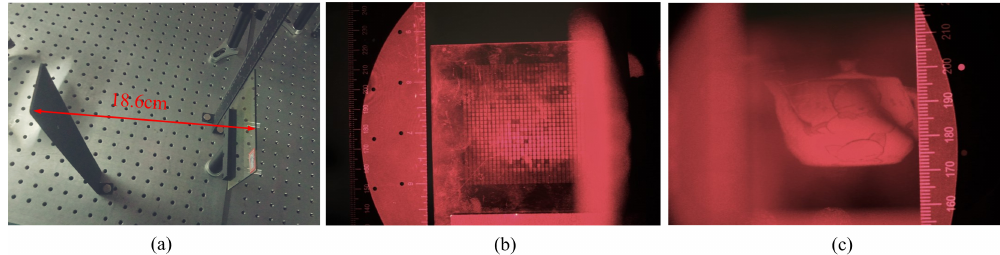
Figure 12. ( a )The spatial position relation of two rulers and the holographic plate. ( b ) Focused on the left ruler, both rulers the holographic plate are clear. ( c ) Focused on the right ruler, both ruler and the surface of the teapot is